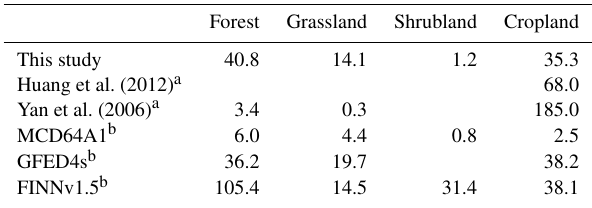
a Emissions estimated by using statistical data. b Refer to Table